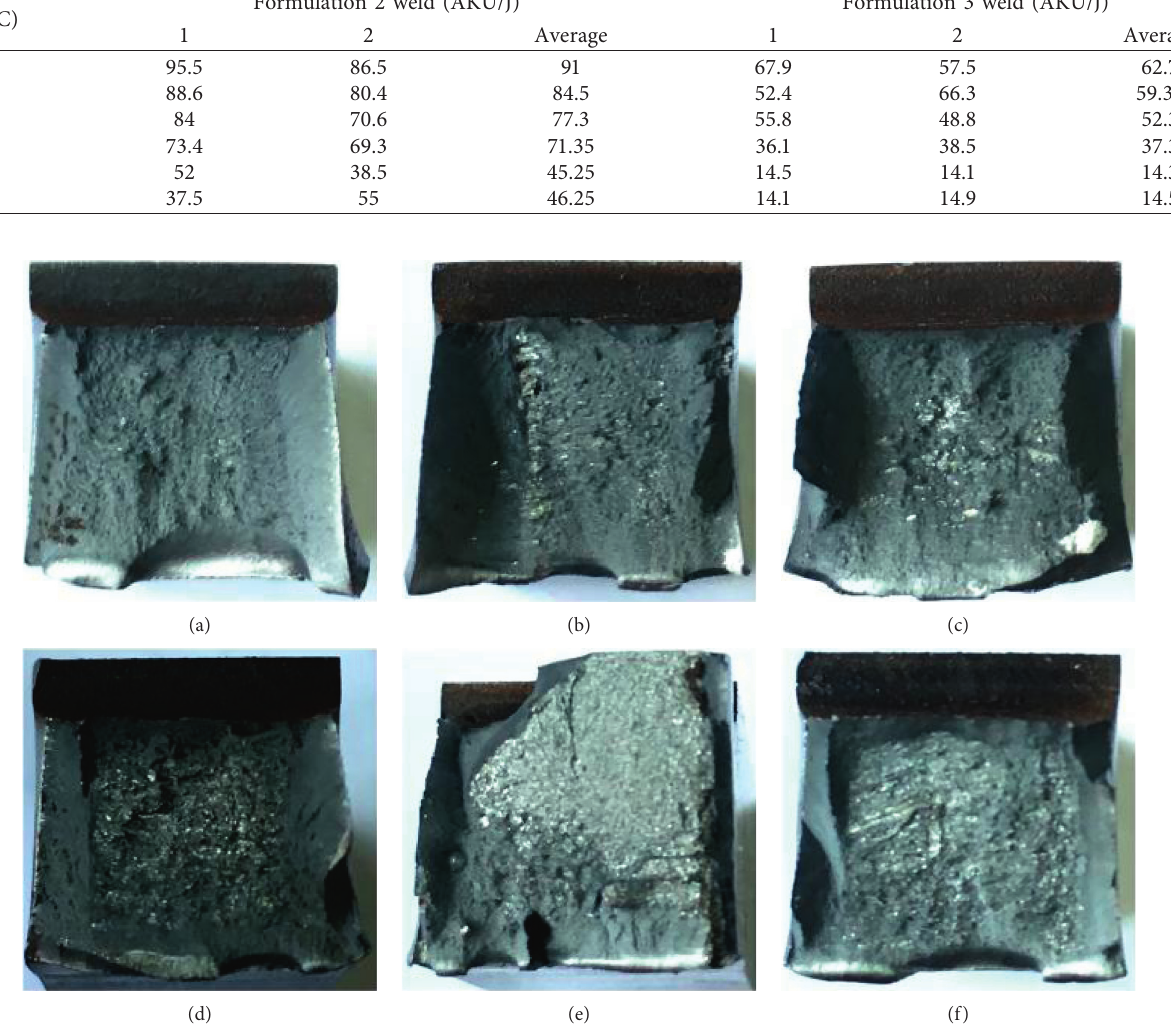
Figure 8: The macromorphology of impact fracture of the notch at different temperatures in the center of the weld. (a) 20 ° C, (b) 0 °